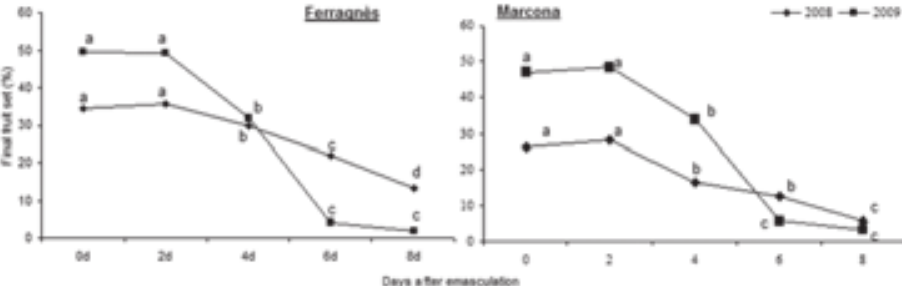
Figure 3. Final fruit set of the studied cultivars after pollination dates from emasculation (day-0) to day-8 over two consecutive years. Different letters indicate differences in fruit set between pollination times in each year ( P <